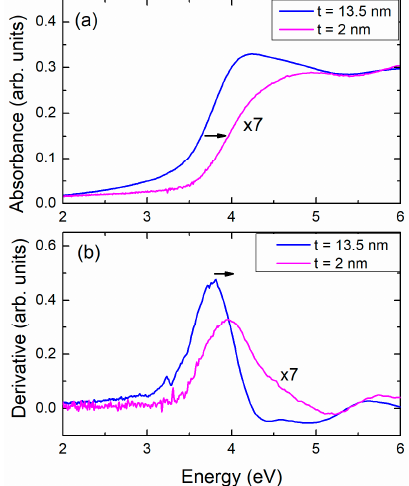
Figure 3. ( a ) Absorbance spectra for two NiO films. The film thickness is indicated. The absorbance of the thinner film has been multiplied by 7 for better clarity. One may see a “blue” shift of the energy band gap as determined by the first derivative of the spectra, see ( b ).